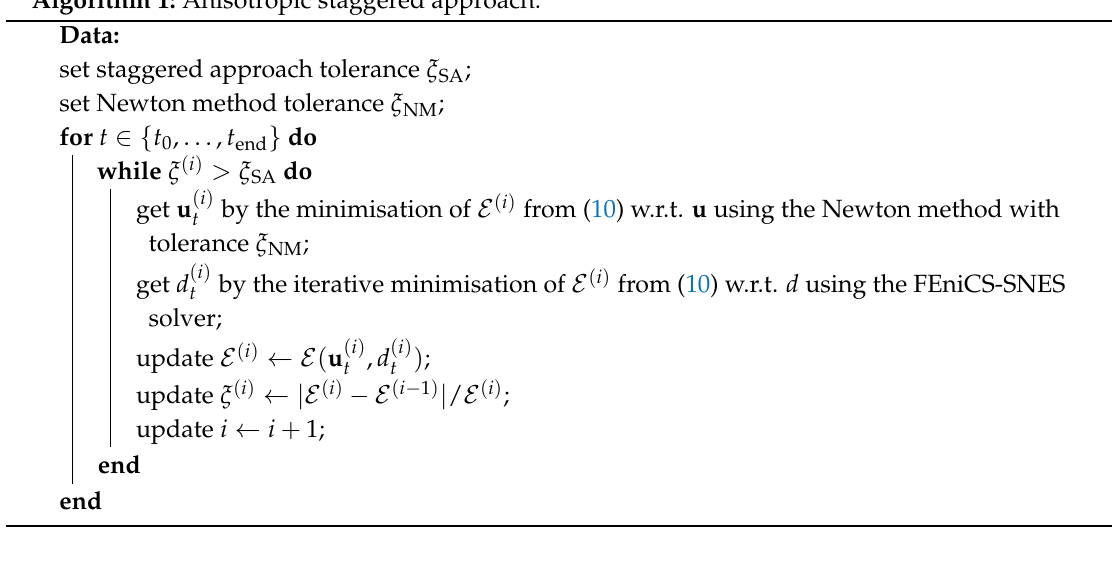
Algorithm 2: Hybrid (isotropic-anisotropic) staggered approach.